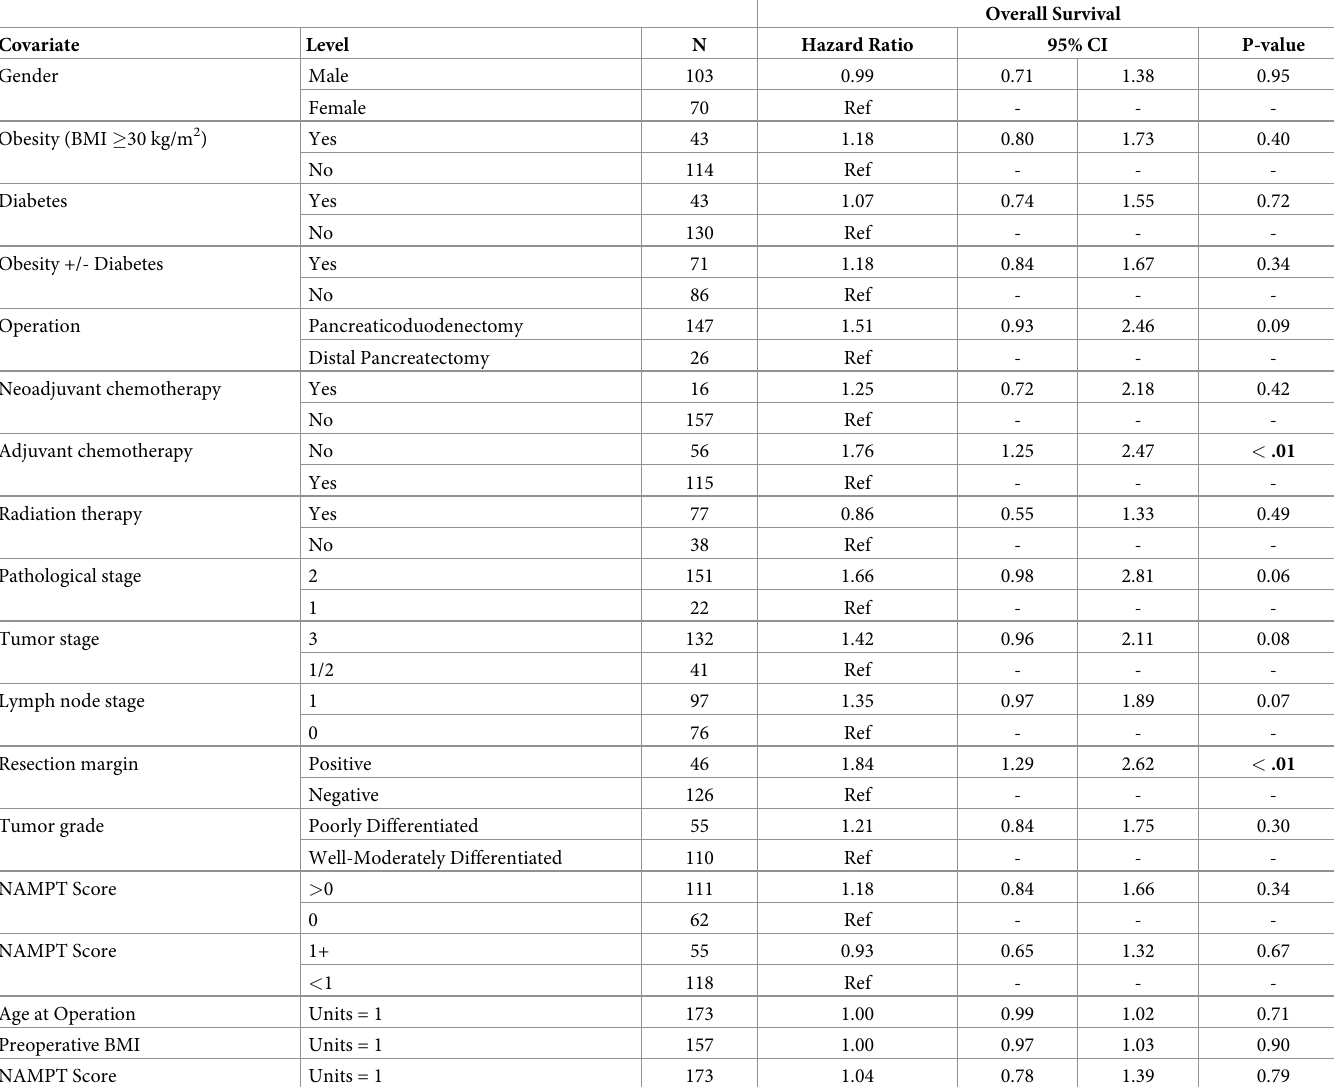
Table 4. Univariate analysis for overall